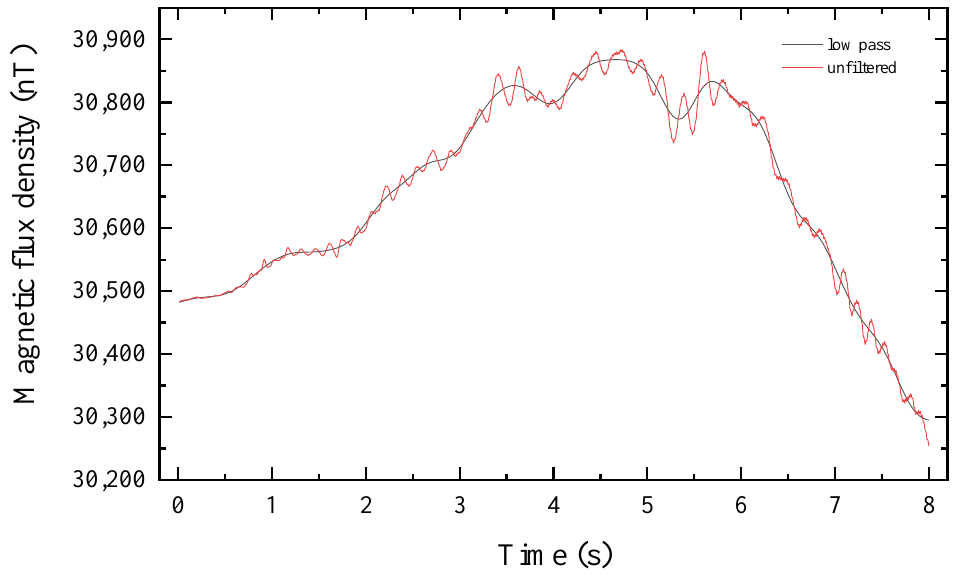
Figure 7. Comparison of time-domain signals before and after filtering.